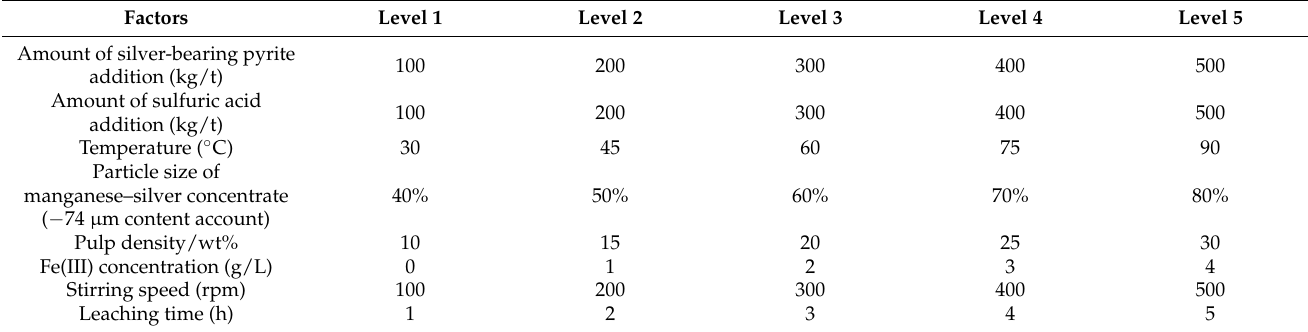
Table 1. The factors and their levels used in the single factor